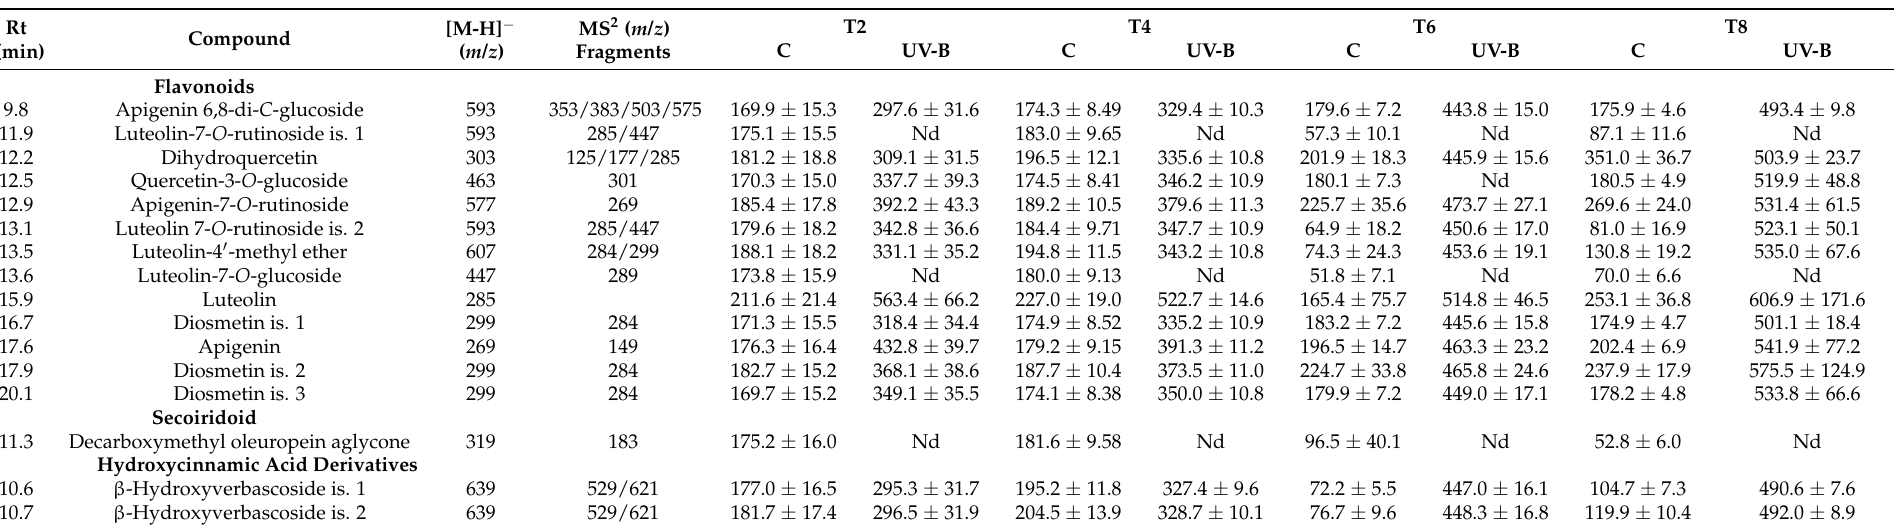
Table 1. Phenolic profile (mg kg − 1 DW) of Olea europaea leaves (Giarraffa variety) under control (C) and UV-B conditions sampled at the 2nd (T2), 4th (T4), 6th (T6), and 8th (T8) week after the onset of stress. Values are mean ± standard deviation ( n = 3–4). Rt—retention time; Nd—not detected; is.—isomer. ANOVA showed that most of chemical components were significantly affected by the main factors and their interactions.